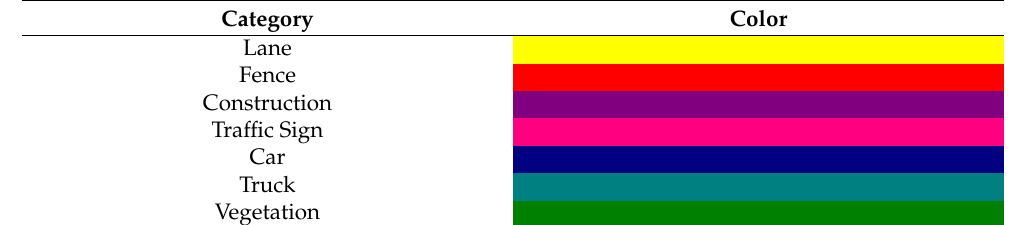
Table 2. Details of mark labels in the